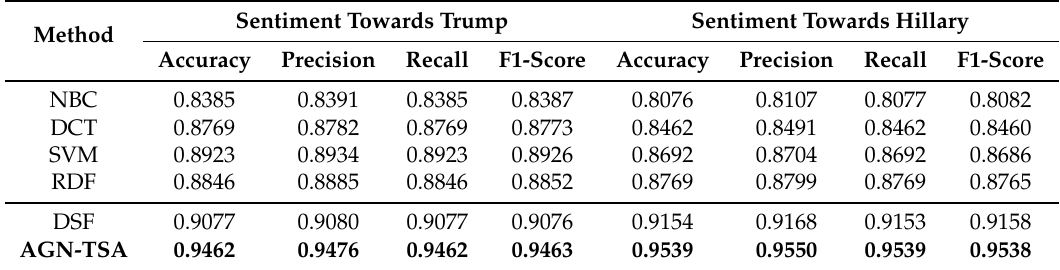
Table 3. Performance comparison between AGN-TSA and traditional